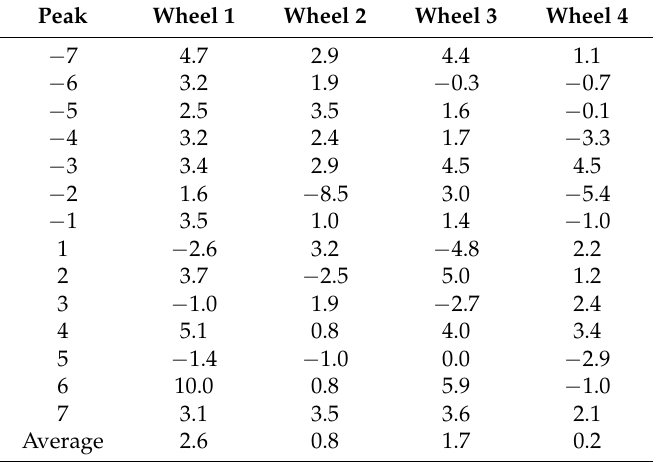
Table 3. Increase percentages of the dynamic wheel loads in the high moisture case comparing to the reference